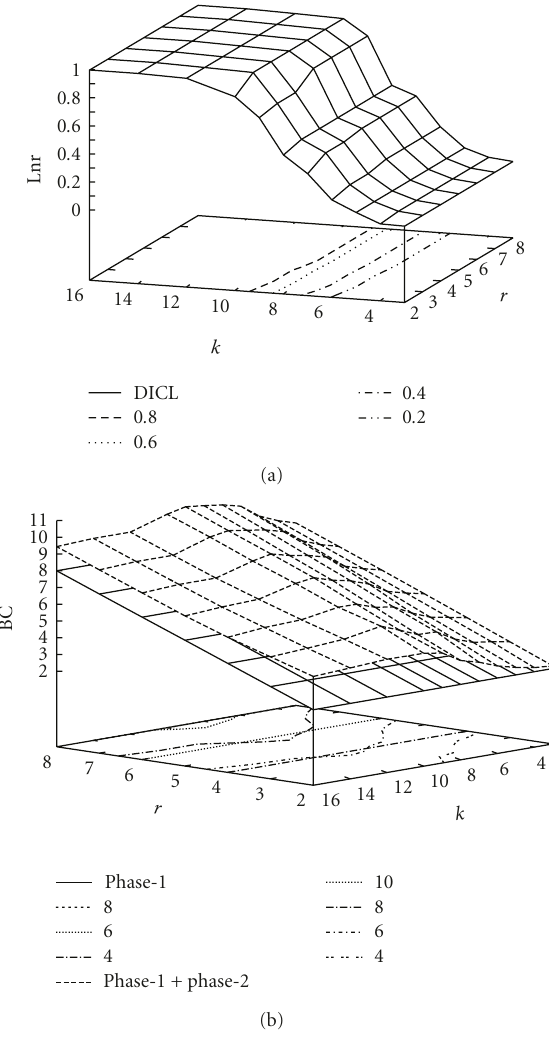
Figure 4: (a) The ratio of localized nodes. (b) Average number of broadcasts per